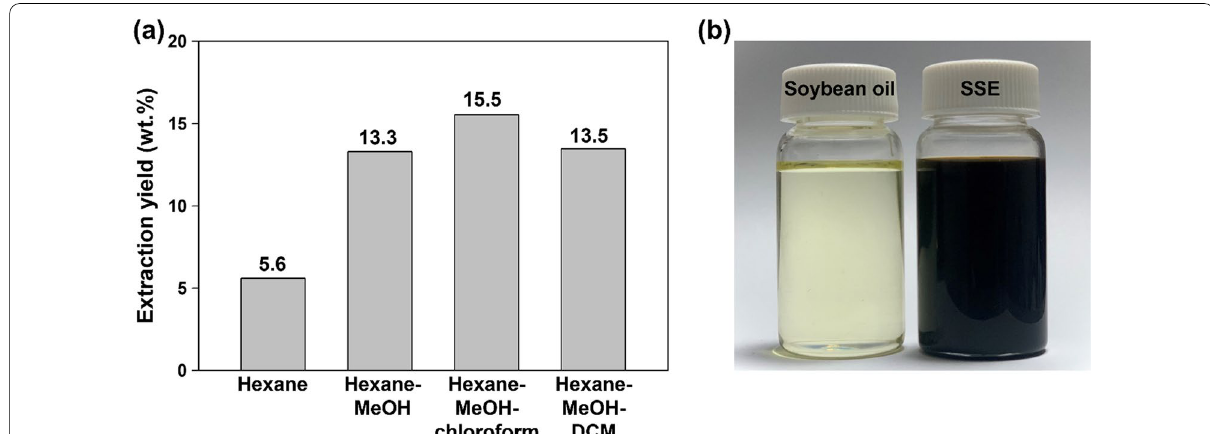
Fig. 1 a Extraction yields from solvent extraction of SS using different organic solvents at 80 °C for 24 h, and ( b ) a photograph of soybean oil and SSE obtained from solvent extraction using hexane/MeOH/chloroform mixture